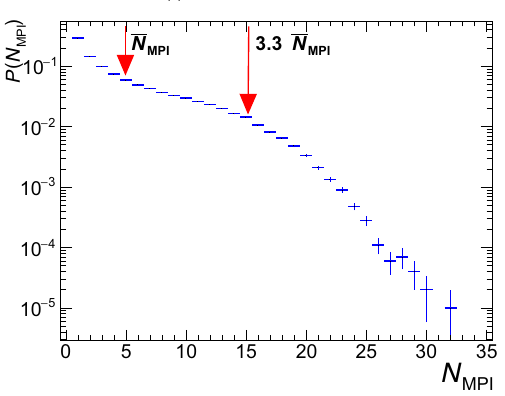
Fig. 3 Left: Average self-normalized number of MPI per event as a function of the self-normalized inverse impact parameter ( b − 1 ). Right: The probability distribution of the number of MPI per event. The arrows